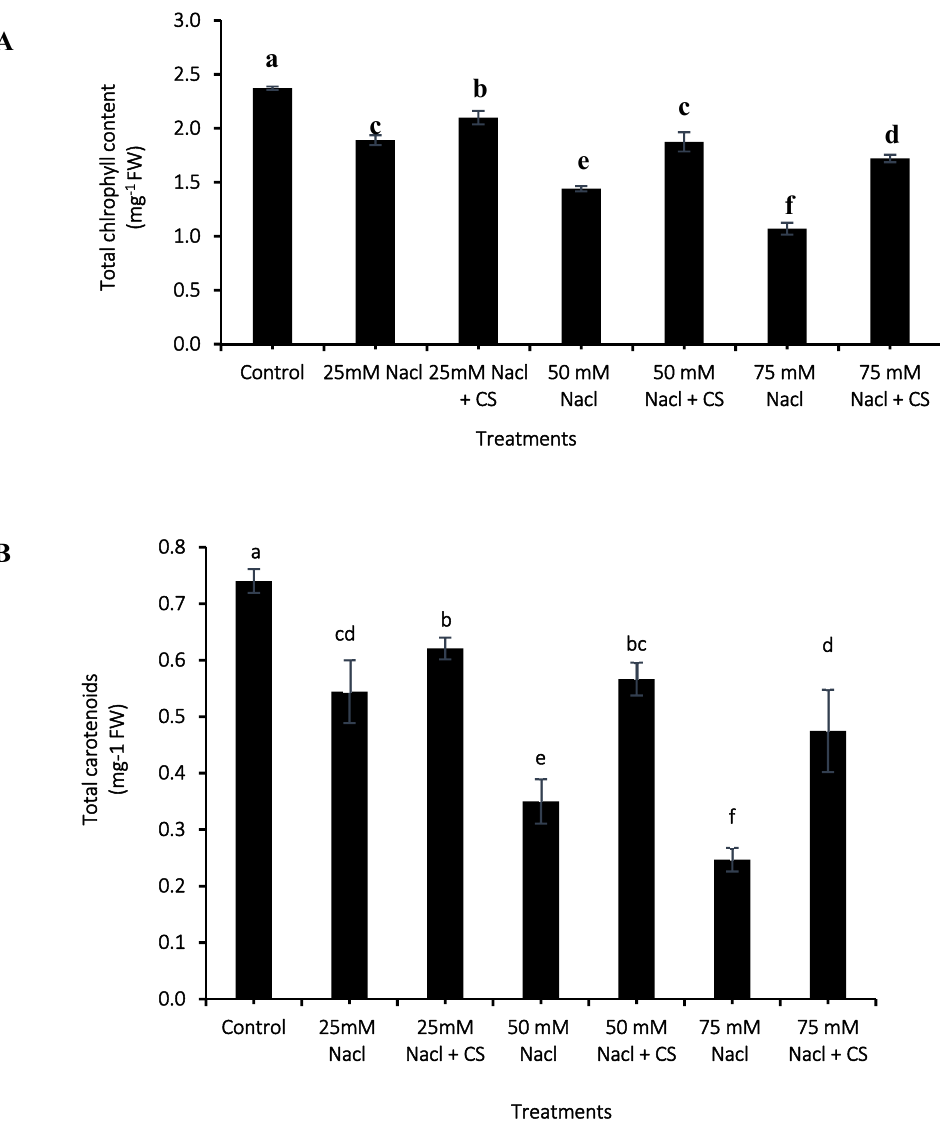
Figure 3. Total chlorophyll ( A ) and total carotenoids ( B ) of Moringa oleifera exposed to salt stress and sprayed with chitosan (CS) at 1% concentration. Values are means ± SD of two experiments ( n = 6). Columns with different letters are statistically different from each other according to LSD test at p ≤ 0.05.